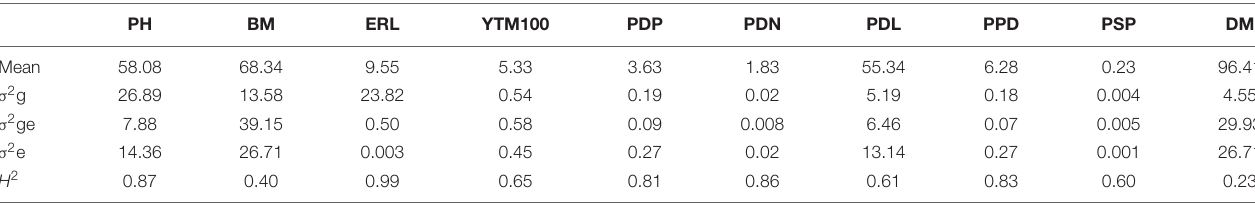
FIGURE 2 | Genetic structure and clustering analysis of 188 wrinkled vining pea genotypes based on 9,602 SNP markers. (A) Inference of optimal sub-groups with the Bayesian clustering model in STRUCTURE. (B) Bar plot for the genetic composition of 188 wrinkled vining pea genotypes in the two STRUCTURE-inferred sub-groups. (C) Unweighted pair group method with the arithmetic mean (UPGMA)-based clustering of genotypes. (D) Heatmap of genotypes based on the identity-by-state (IBS) kinship similarity matrix. TABLE 1 | Estimated genetic variance, genotype-by-environment (G × E) interaction variance and residual variance components, and broad-sense heritability of agronomic and downy mildew resistance traits of wrinkled vining pea genotypes.